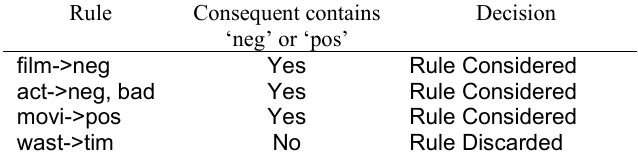
Table 2. Association rules generated on IMDB Movie Review Dataset